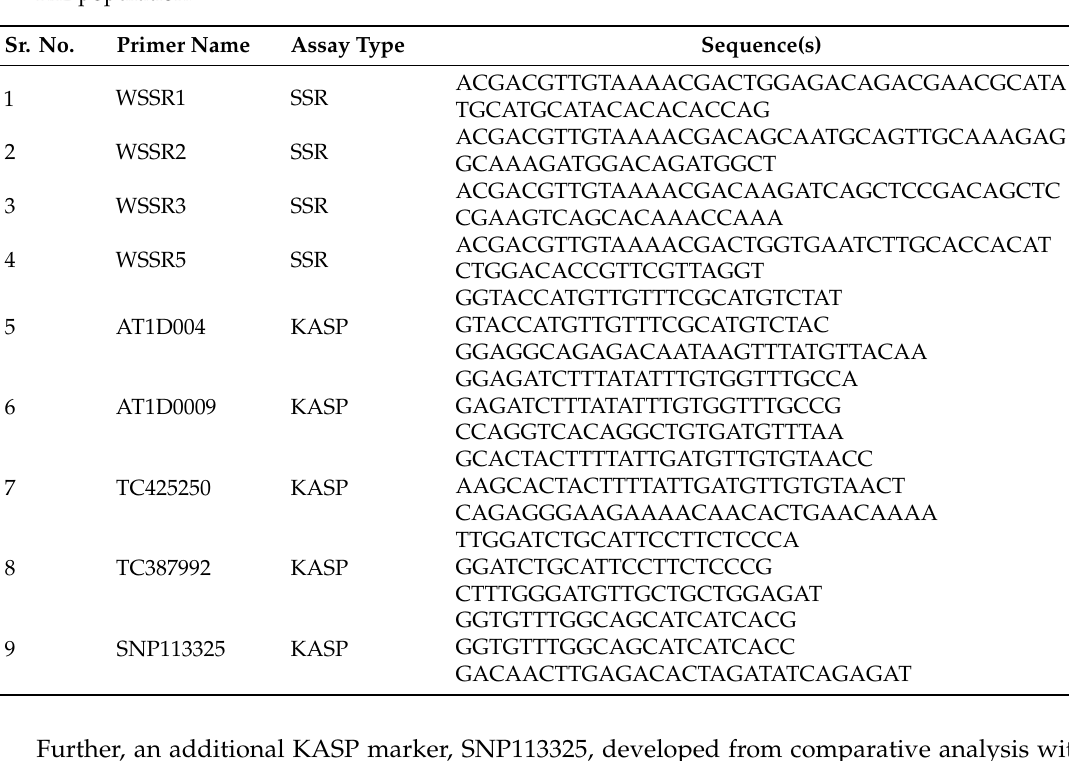
Table2. Simplesequencerepeat(SSR)andKASPmarkersdevelopedandmappedontheKS93U50 / Morocco RIL population.